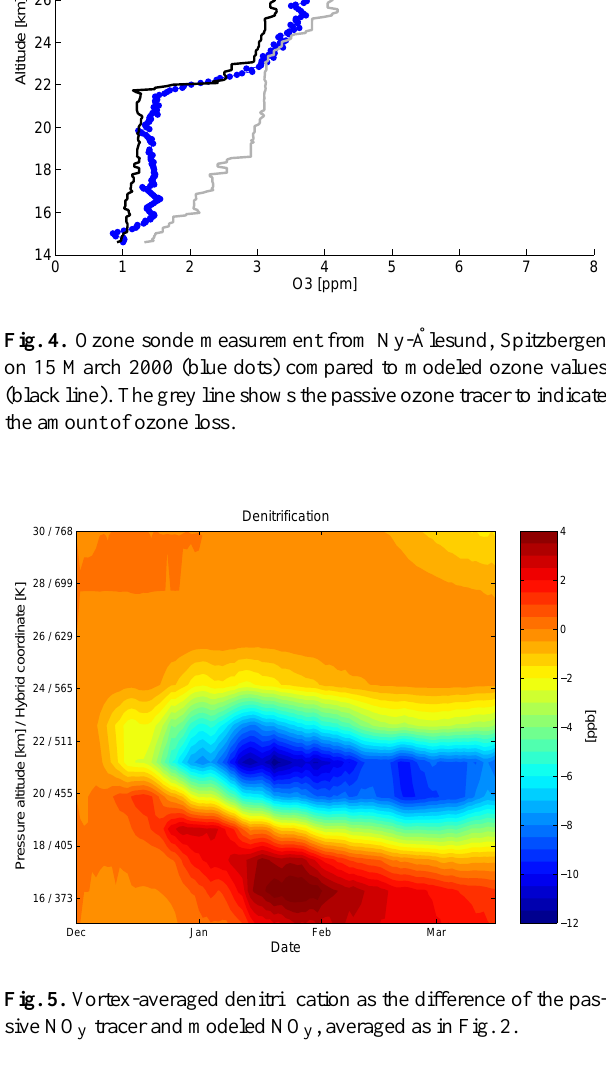
BrONO 2 is assumed to contain all Br y , which is taken from a Br y -CH 4 relationship from ER-2 data in Grooß et al. (2002), with Br y again deduced from the measured organic source gases. The relationship does also contain a contri- bution from some short-lived source gases of 2–3 ppt. The relationship is only valid for methane values smaller than 1.64 ppm, for values between 1.64 and 1.8 ppm, Br y values are decreased from 6 ppt to 0 ppt. The obtained Br y is scaled by a constant factor to give maximum Br y values of 19.9 ppt to agree with Differential Optical Absorption Spectroscopy (DOAS) measurements of BrO (Dorf et al.,